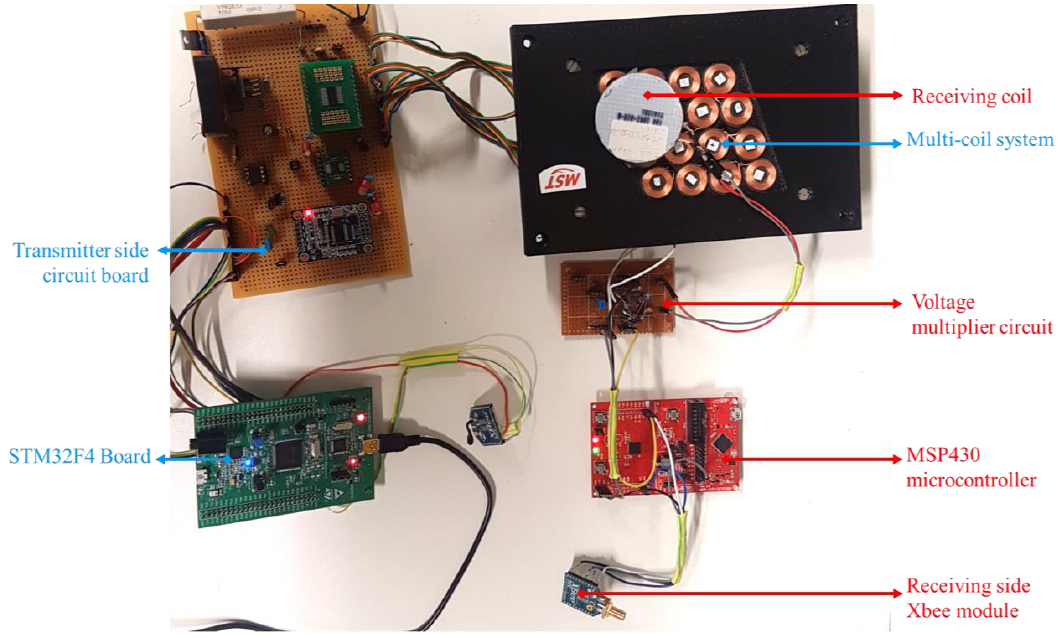
Figure 16. Experimental setup during the powering process .